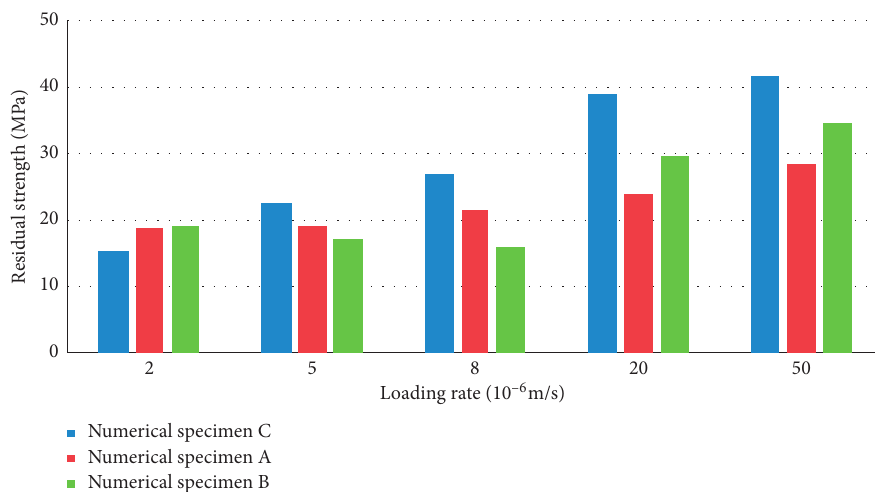
Figure 9: Longitudinal contrast of residual strength of three kinds of numerical